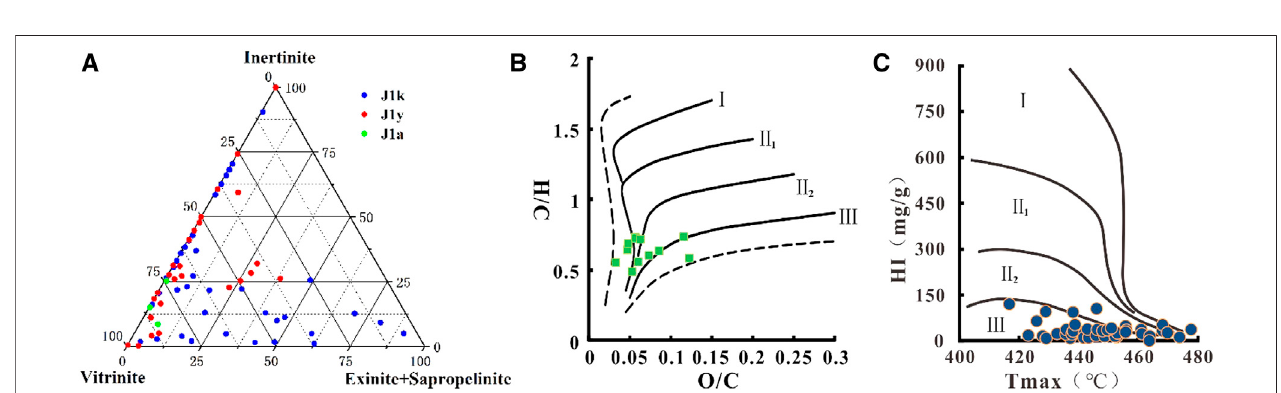
FIGURE 5 | (A) Triangles of kerogen macerals of Lower Jurassic shale in the Tarim Basin (according to the modi fi cation of Xiao Zhongyao, 2003; Zhao Mengjun, 2001). (B) Fan ’ s diagram of element composition of Lower Jurassic kerogen in the Kuqa Depression. (C) Organic matter types of Lower Jurassic shale in the Southwestern Tarim